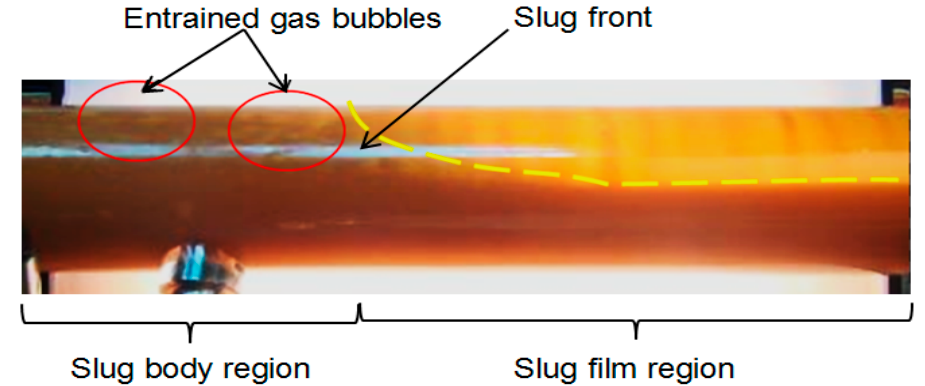
Figure 6. A typical Slug flow for gas and high viscosity oil flow observed for this study (figure from Archibong-Eso et al. [7]).